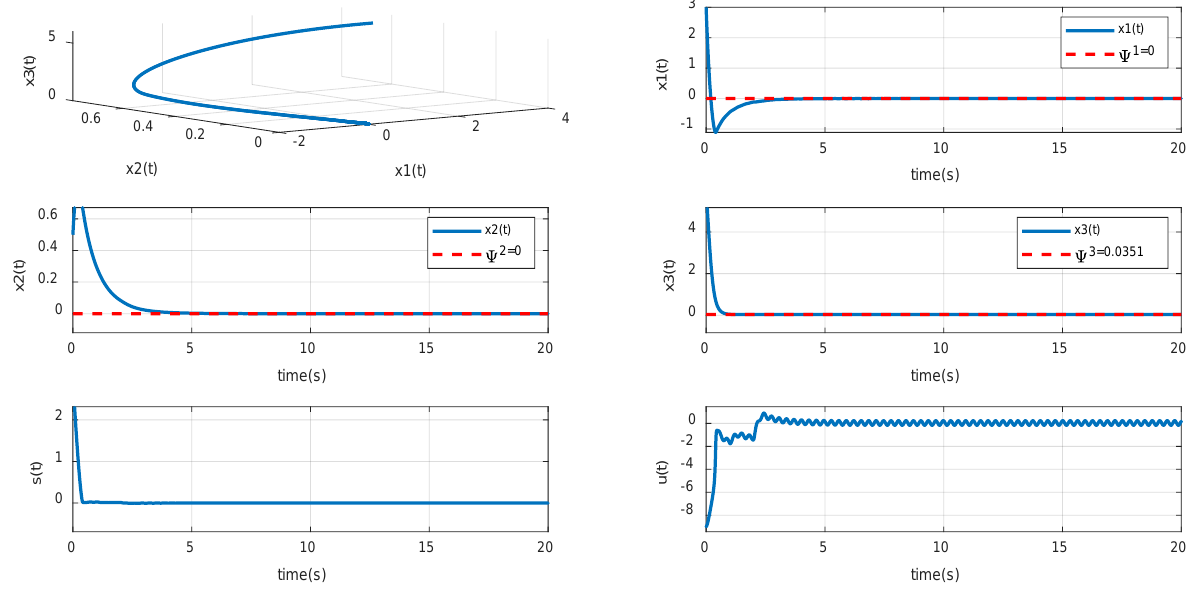
Figure 3. The system dynamics of controlled Rössler systems with unknown time delays and matched uncertainty.